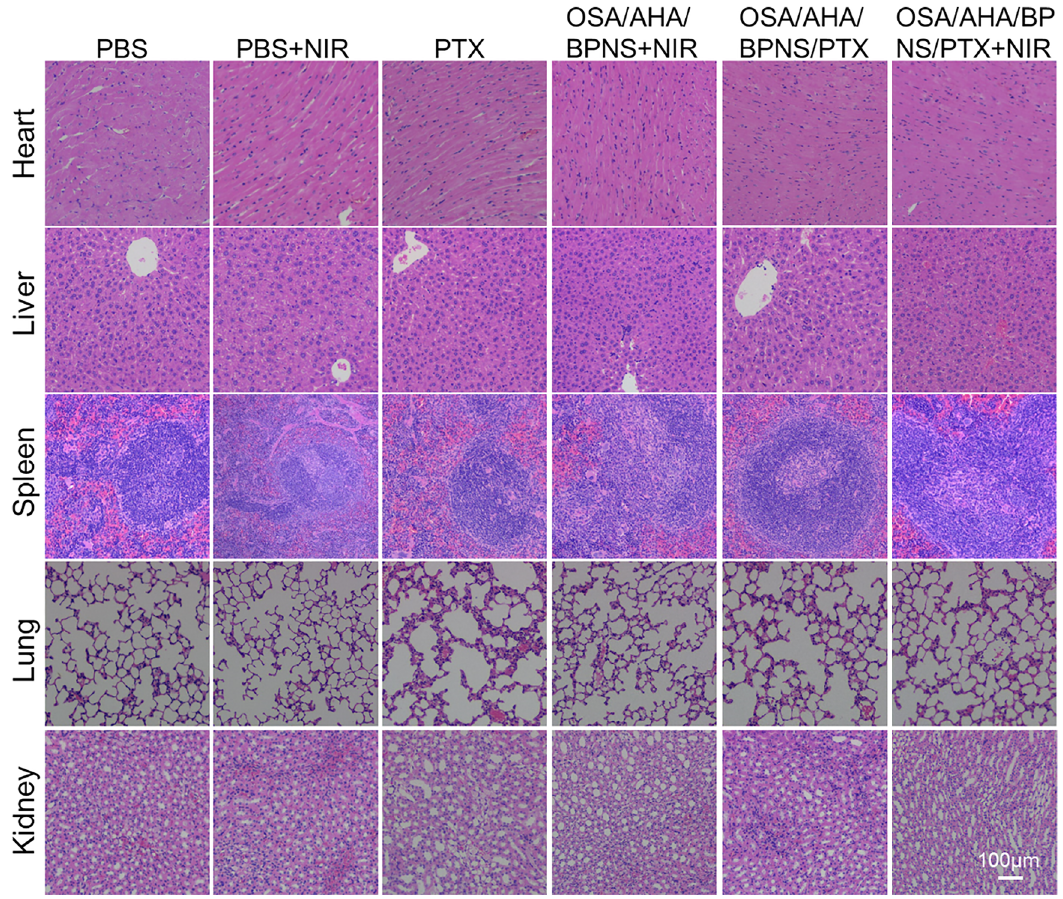
Figure 6: In vivo biocompatibility evaluation of materials, H&E staining images of mice organs underwent different treatments for 14 days. Note that 1 – 6 represent mice groups with different